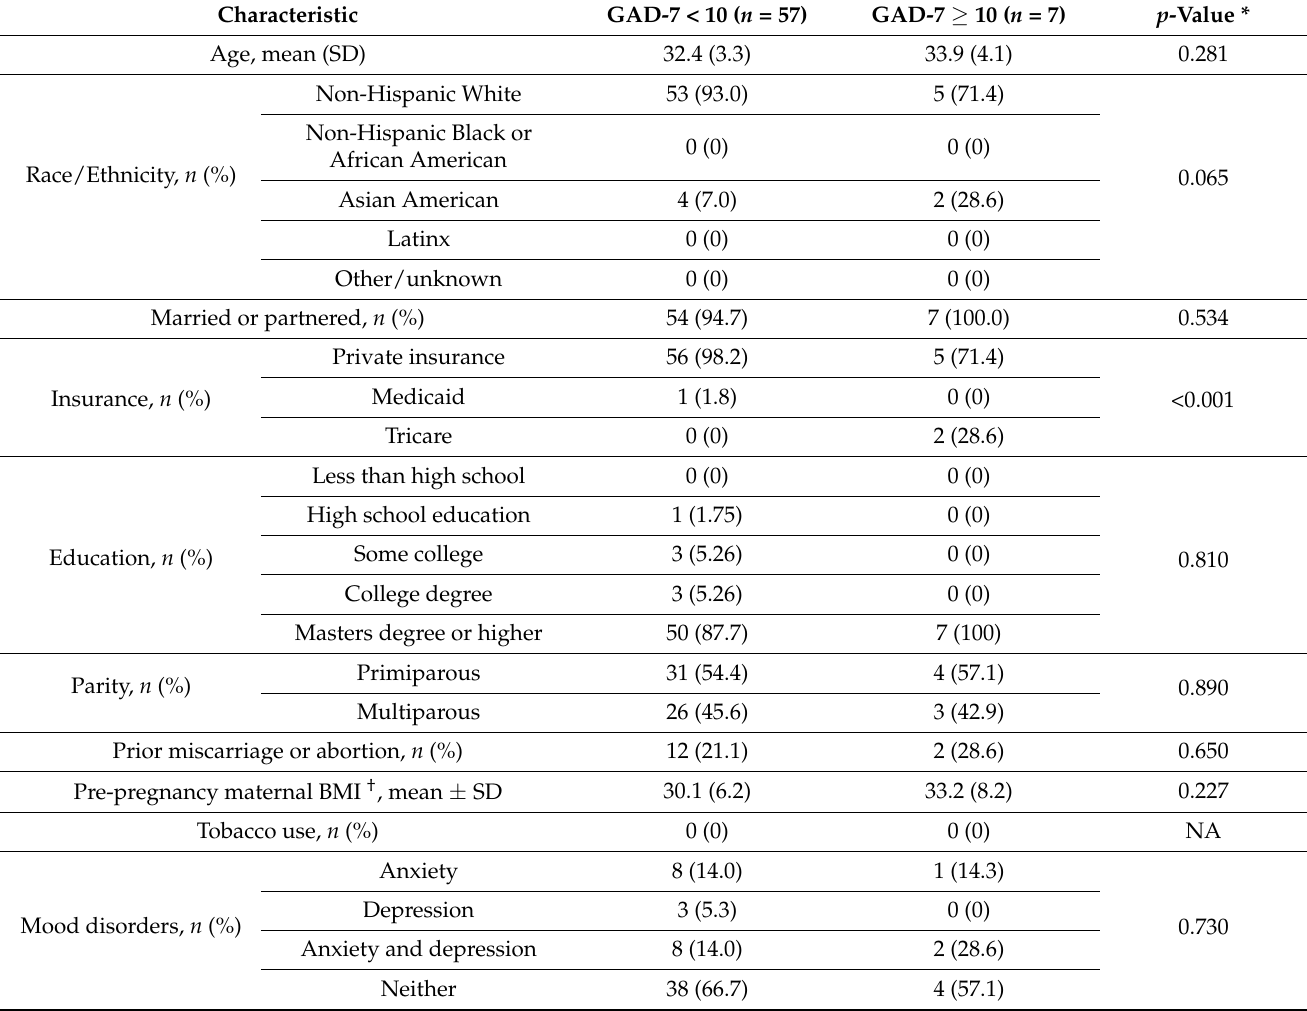
Table 1. Maternal